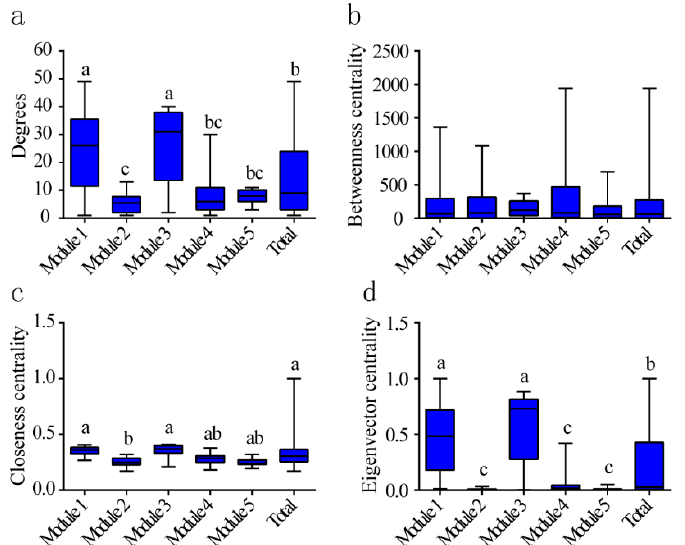
Figure 5. Co-occurrence network with ASVs colored by taxonomy ( a ) and modularity ( b ), respec- tively. The size of each node is proportional to the number of connections. Each connection has a Spearman’s correlation coefficient > |0.8| and a p -value < 0.01. A grey edge in ( a ) indicates positive interaction, while a red edge indicates negative interaction.